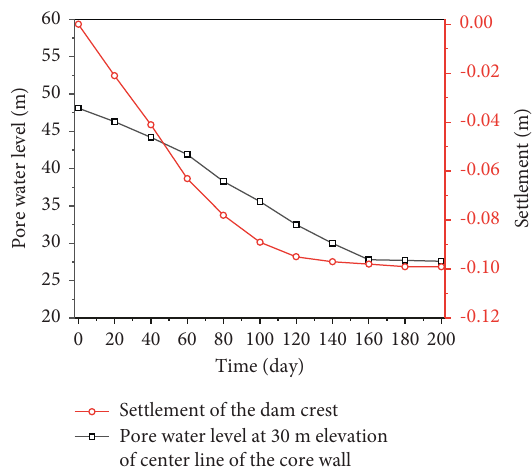
Figure 7: Variation curve of dam crest settlement with time after the sharp drop in the storage level.